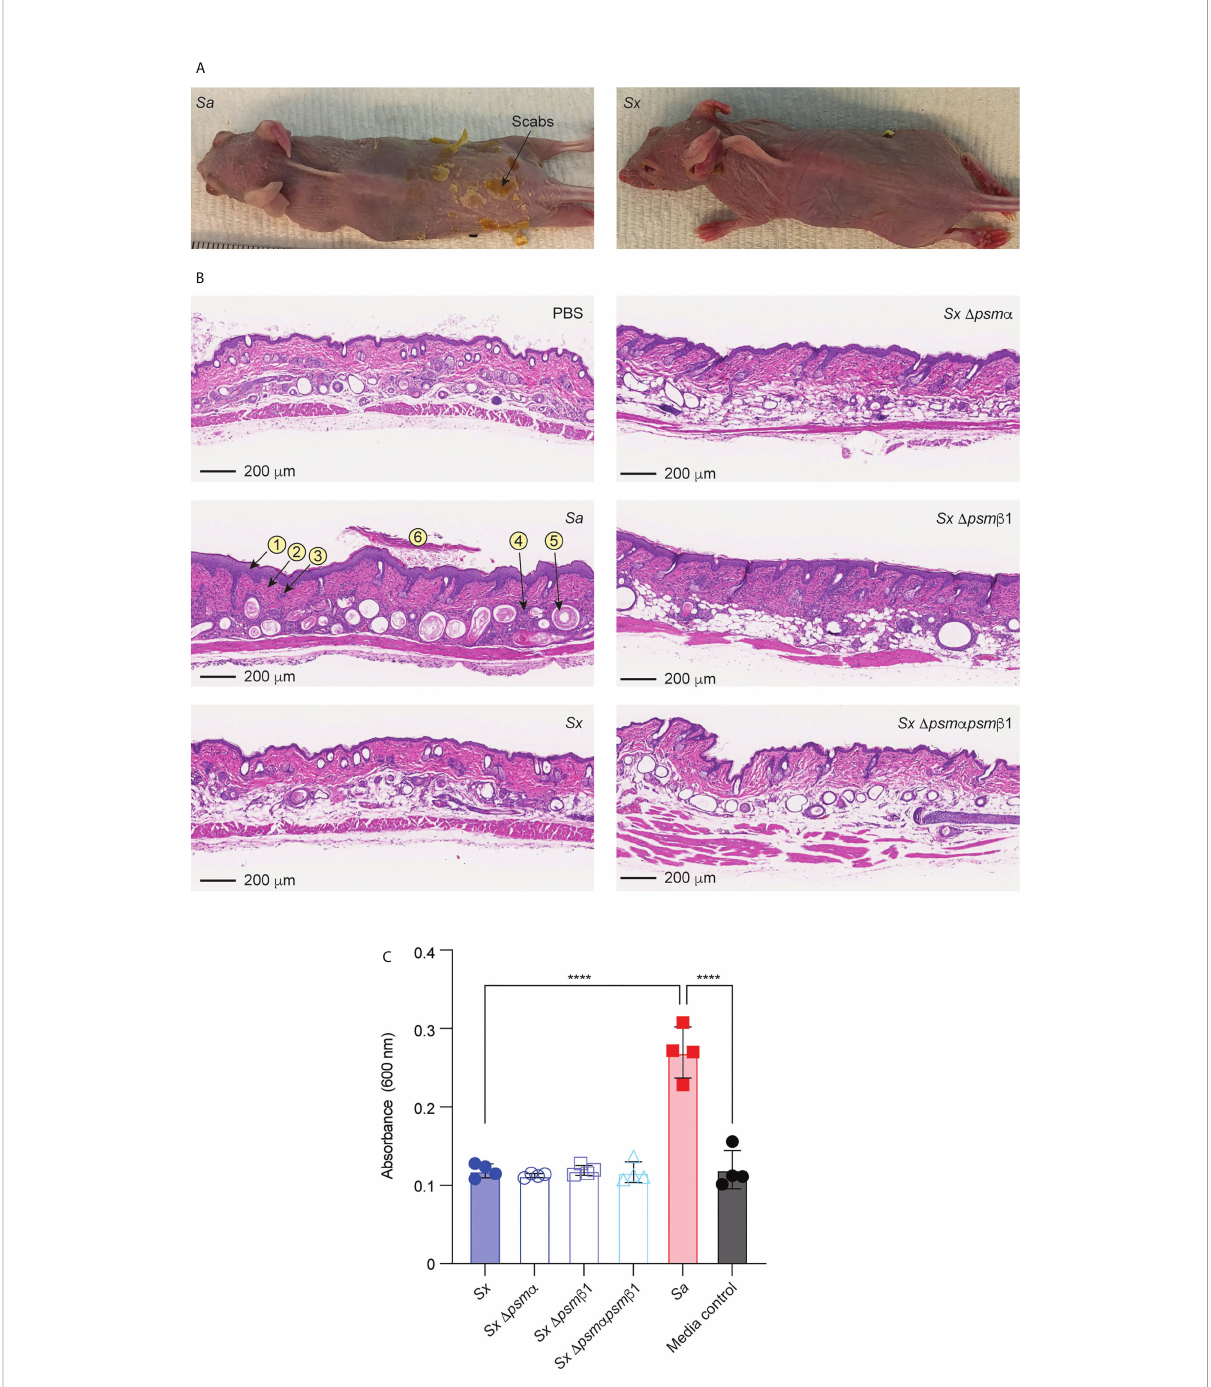
FIGURE 7 Mouse model of AD and in-vivo mast cell degranulation. (A) Representative pictures of mice infected on the skin with S. aureus LAC ( Sa ) and S. xylosus AG14 ( Sx ). (B) Histological evaluation of mice infected with S. aureus LAC, S. xylosus AG14 or isogenic S. xylosus psm mutants. See Table 2 for scores. Signs of in fl ammation and infection are marked in the S. aureus picture: 1, diffuse hyperplasia; 2, dermal in fl ammation; 3, focal hyperplasia; 4, follicular in fl ammation; 5, follicular dilation; 6, hyperkeratosis. These are absent or much less pronounced in all other pictures. (C) Mast cell degranulation in vivo as determined by a Protein-fragment complementation assay (PCA). Measurements were performed from both ears from two mice after injection with culture fi ltrates. Statistical analysis is by 1-way ANOVA with Tukey ’ s post-tests. ****, p < 0.0001; Error bars show the mean ±